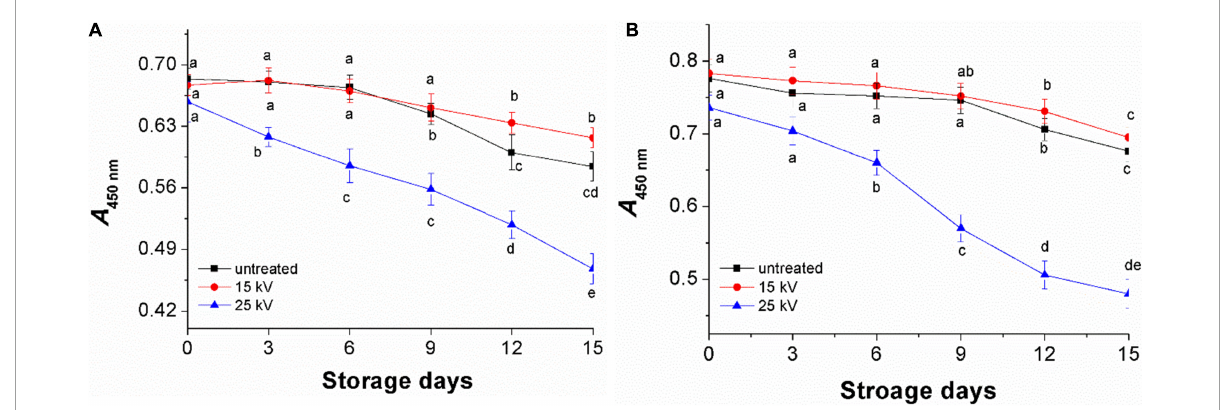
FIGURE6 The changes of yellow pigment of foxtail millets during accelerated agingstorage. (A) Mizhi. (B)